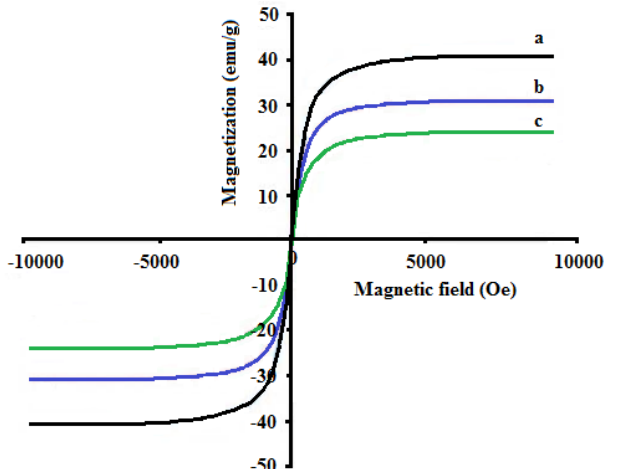
Fig. 3: VSM analysis of Fe